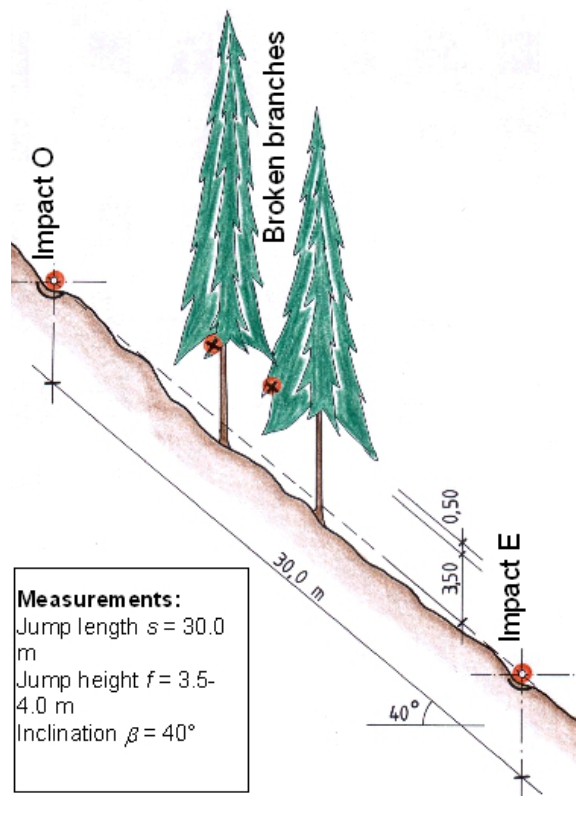
Fig. 7. Schematic illustration of rockfall traces on the ground and tree branches f/s = 1 / 12 for shallow jumps